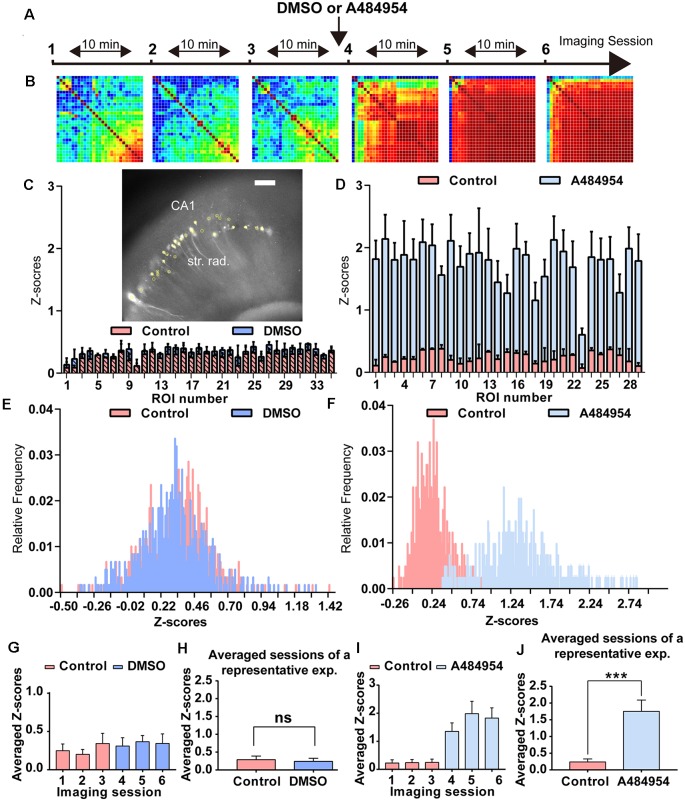
Analysis of the degree of cross-correlation between different areas of the CA1 region of representative time-lapse imaging experiments under control condition and after application of A484954. (A) The schema indicates the sequence of time-lapse fluorescence imaging and the time point of A484954 (10 μM) application. (B) Heat maps are presented for every imaging session showing color-coded the PC value for each ROI pair. Red corresponds to a value of 1 (maximal positive cross-correlation) and blue to a value of −1 (maximal negative cross-correlation). Under drug-free conditions, the imaging sessions revealed only a moderate cross-correlation between fluorescence transients of ROI pairs. However, after application of A484954, the number of correlative coupled pairs increased strongly. (C) The insert shows a representative hippocampal slice with its GCaMP6s-expressing CA1 neurons (white spots). The yellow filled circles indicate ROIs. The bar graph represents superimposed Z scores of PCs for each ROI under control (first three sessions, light pink) and dimethyl sulfoxide (DMSO) application (last three sessions, blue). (D) In a different representative example, the application of A484954 (10 μM) evoked an increase of cross-correlation coefficients in comparison with the drug-free sessions. The Z scores have been depicted in the bar graph for the two conditions. (E) The frequency distribution of Z scores has been presented in a histogram for sessions 3 and 6. (F) This histogram shows that the relative frequency distribution changed after drug application to the right. (G) For statistical comparison, the mean and SEM of Z scores over every pair were calculated and depicted in the bar graph for every session. (H) The bar graph shows that there is no difference in the average of Z scores of the first three control sessions (0.29 ± 0.10) followed by three DMSO sessions (0.24 ± 0.09; ns, paired t-test). (I) The bar graph summarizes the results for every session in the control–drug experiment. (J) The bar graph shows that averaged Z scores of three sessions differ significantly between the two conditions (control: 0.24 ± 0.09; A484954: 1.75 ± 0.34; ***P < 0.01, paired t-test).